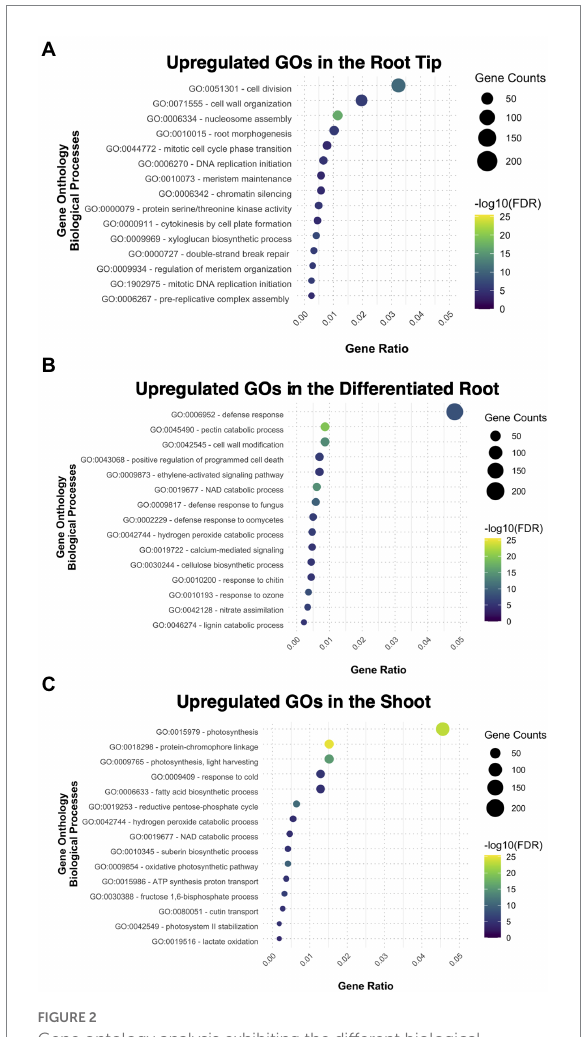
FIGURE 2 Gene ontology analysis exhibiting the different biological processes upregulated and enriched in each tissue: (A) the root tip, (B) the differentiated root, and (C) the